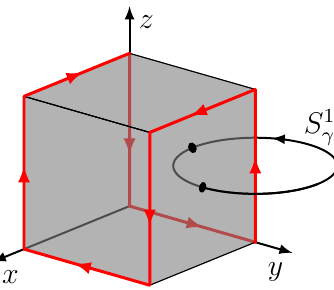
Figure 6: The choice of the S 1